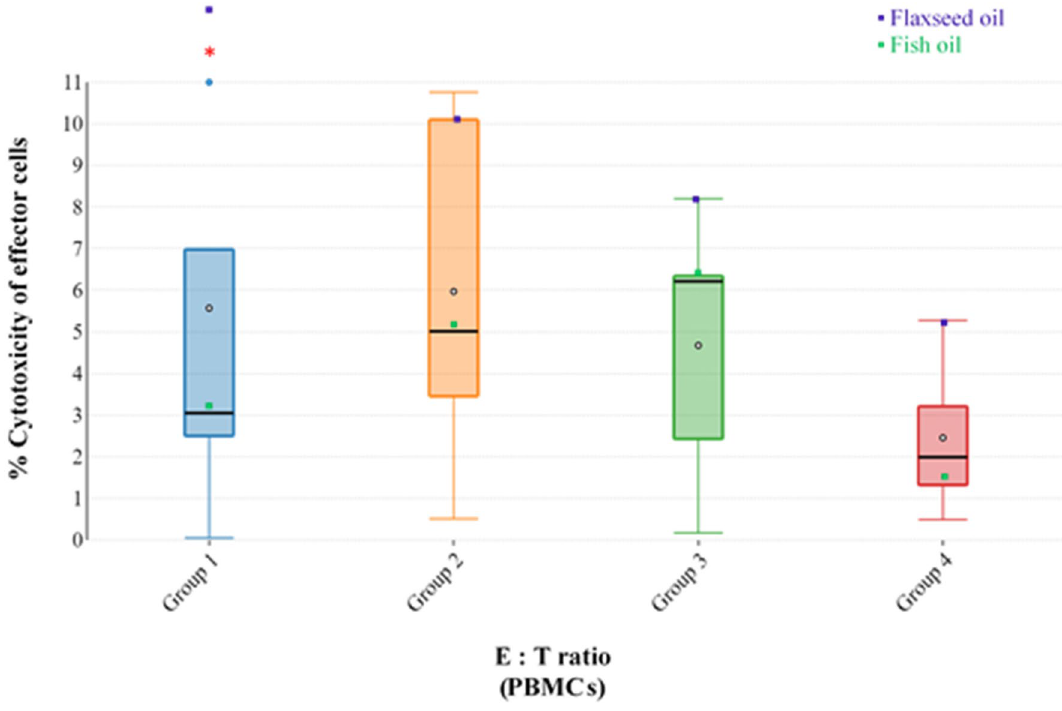
Figure 2. Effect of feeding the experimental dietary treatments on cytotoxic cell activity of PBMCs from 5-week old broilers. Group 1: E:T ratio of 100:1, Group 2: E:T ratio of 50:1, Group 3: E:T ratio of 25:1 and Group 4: E:T ratio of 12.5:1; only statistically significant results obtained from one-way ANOVA are represented by red asterisks (P ≤ 0.05).